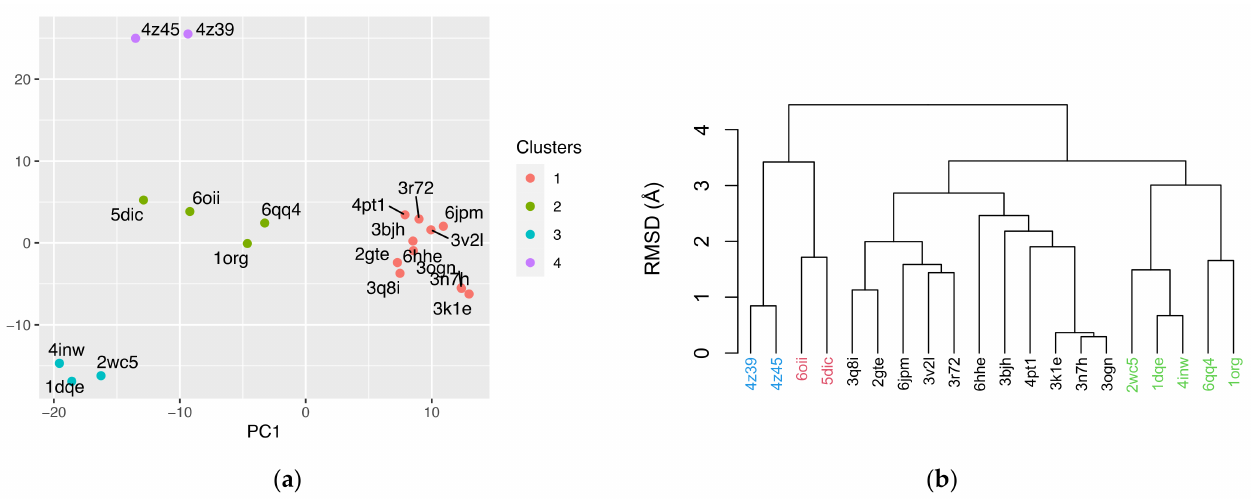
Figure 5. The PC scores in the 20 structures in the dataset, calculated from the deviation in C α positions. PC1 and PC2 capture 32.2% and 27.3% of the cumulative structural variance, respectively (Panel a ). Clustering of OBPs based on RMSD similarity (Panel b ).